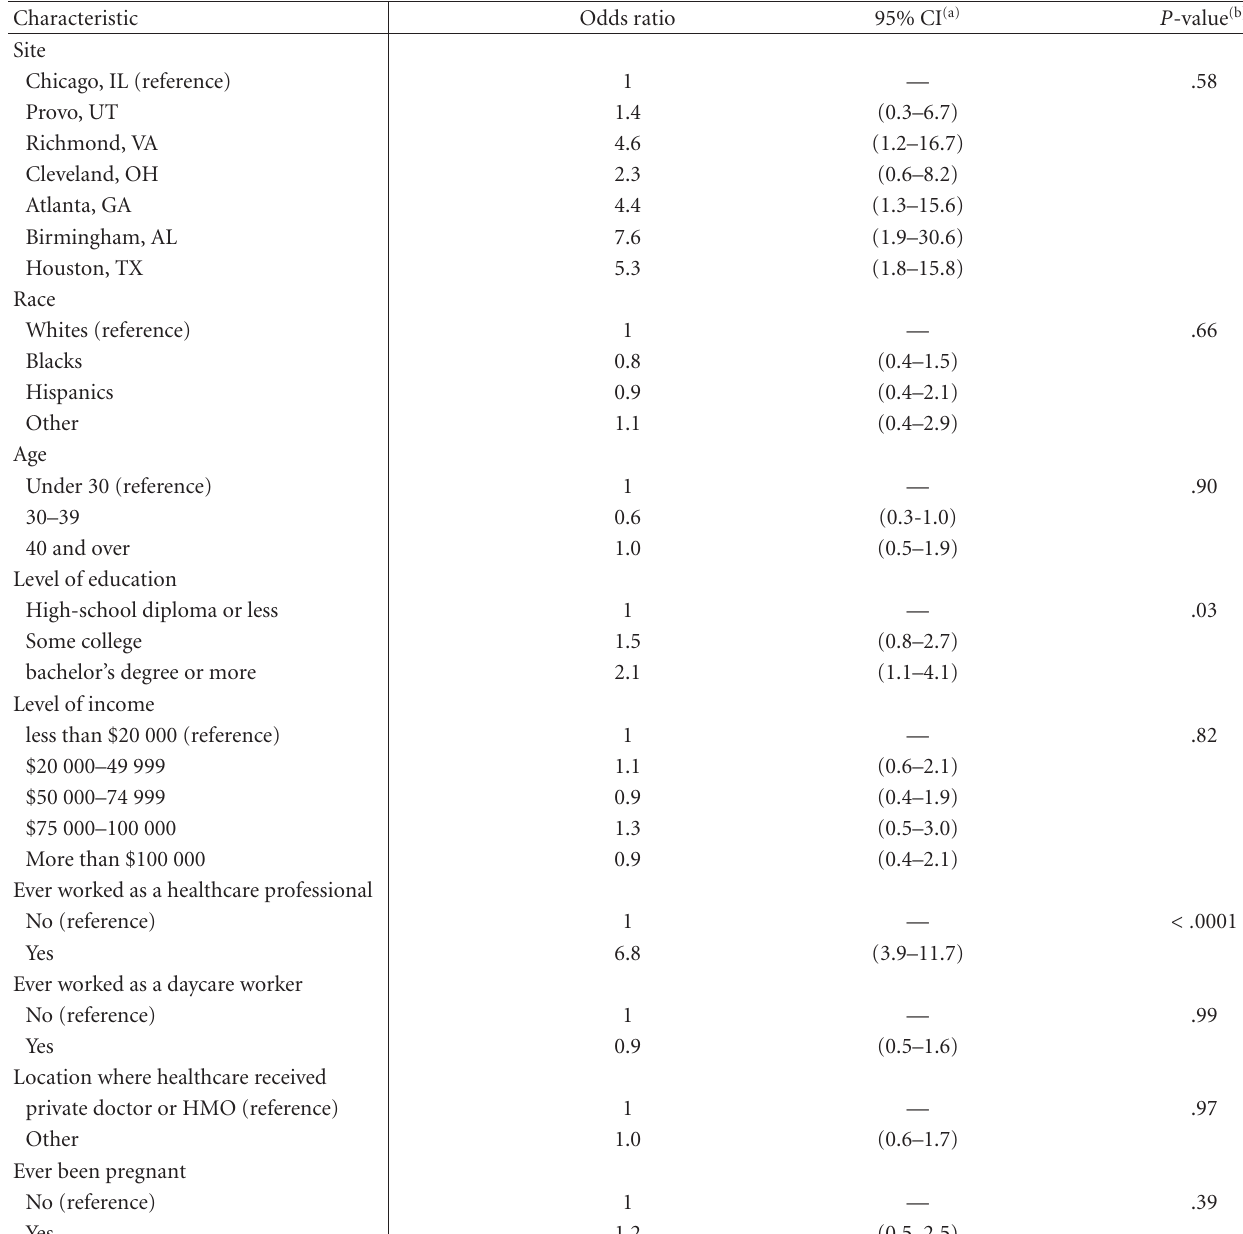
Table 2: Logistic regression summary: awareness of congenital CMV among women. Some categories were collapsed in the multivariate analysis because of small numbers in the categories.